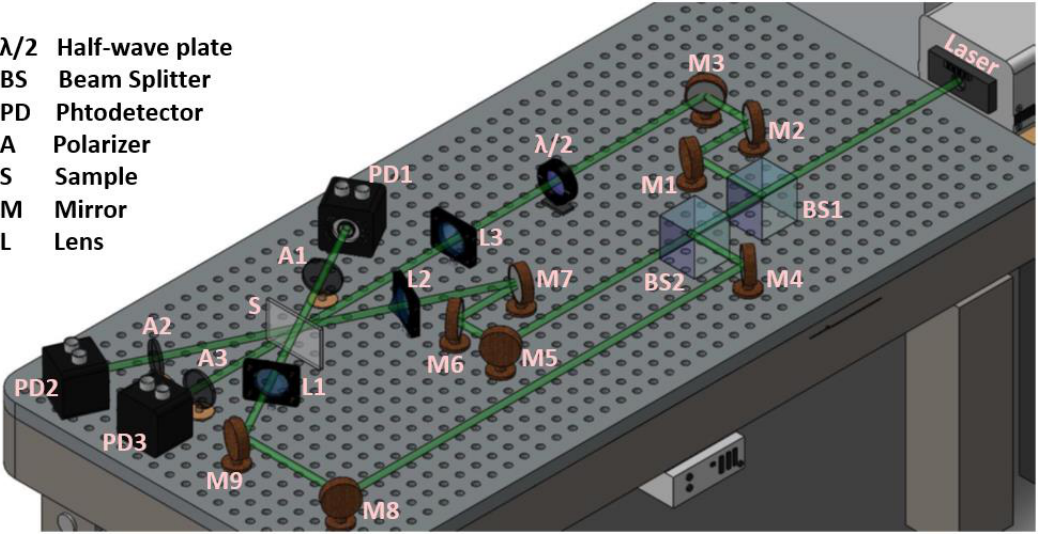
Figure 1. Schematic illustration of the two-wave mixing experiment.